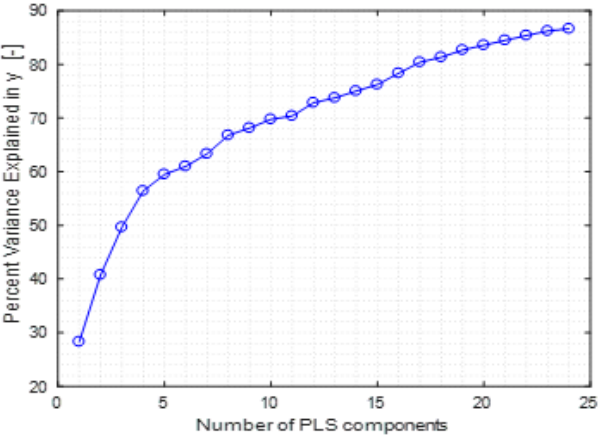
Figure 12. Cumulative Variance in function of the PLS component number. Table 2 . Performance Indexes using PLSR.